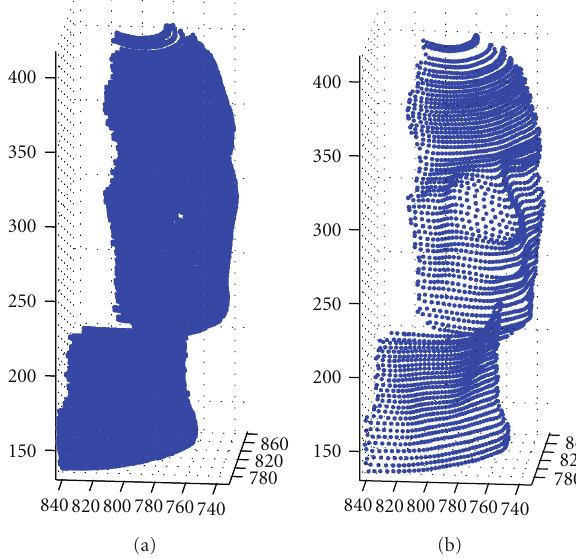
Figure 7: (a) Starting cloud of points; (b) cleared cloud of points.